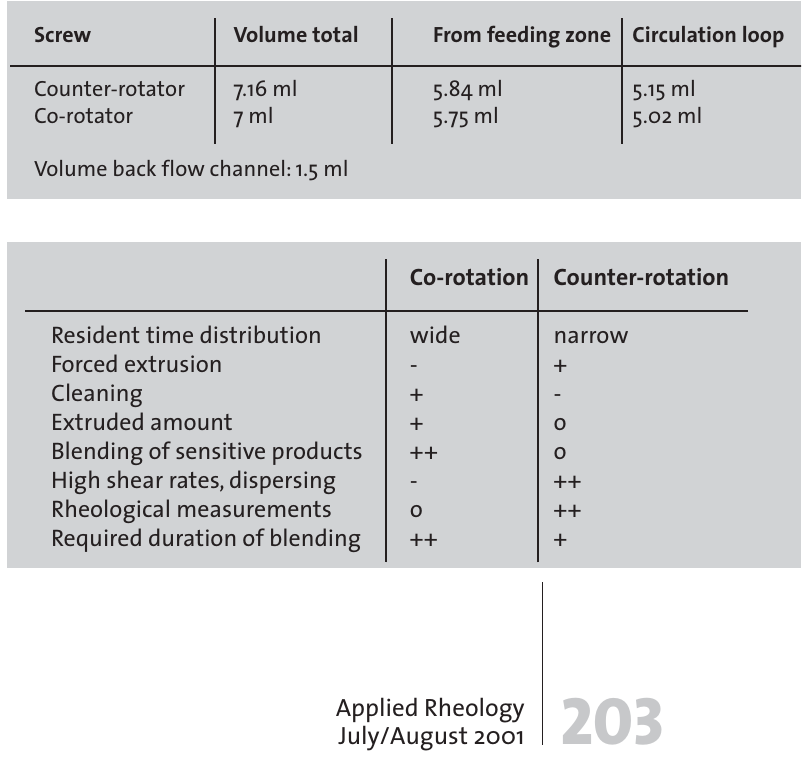
Table 1 (above): Filling volume. Table 2 (below): Characteristics of the screw